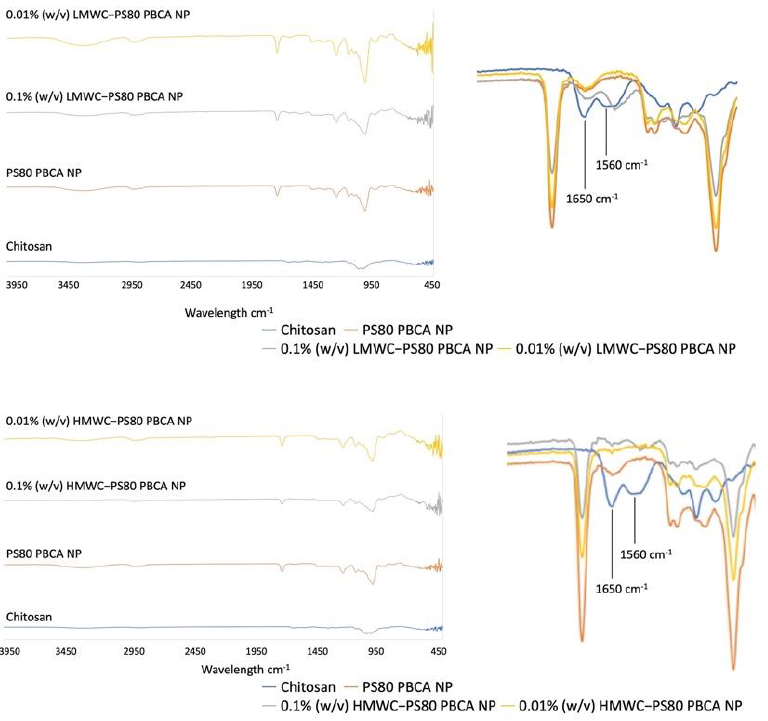
Figure 2. The attenuated total reflectance Fourier transform infrared spectroscopy of the PS80 PBCA NP surface-modified with 0.1% ( w / v ) and 0.01% ( w / v ) LMWC and HMWC revealed distinct absorption bands characteristic of chitosan (blue line) near the 1560 cm − 1 and 1650 cm − 1 regions (right panel of the figure), which were evident for nanoparticles coated with LMWC or HMWC of 0.1% ( w / v , gray lines) but were undetectable for the 0.01% ( w / v , yellow lines)